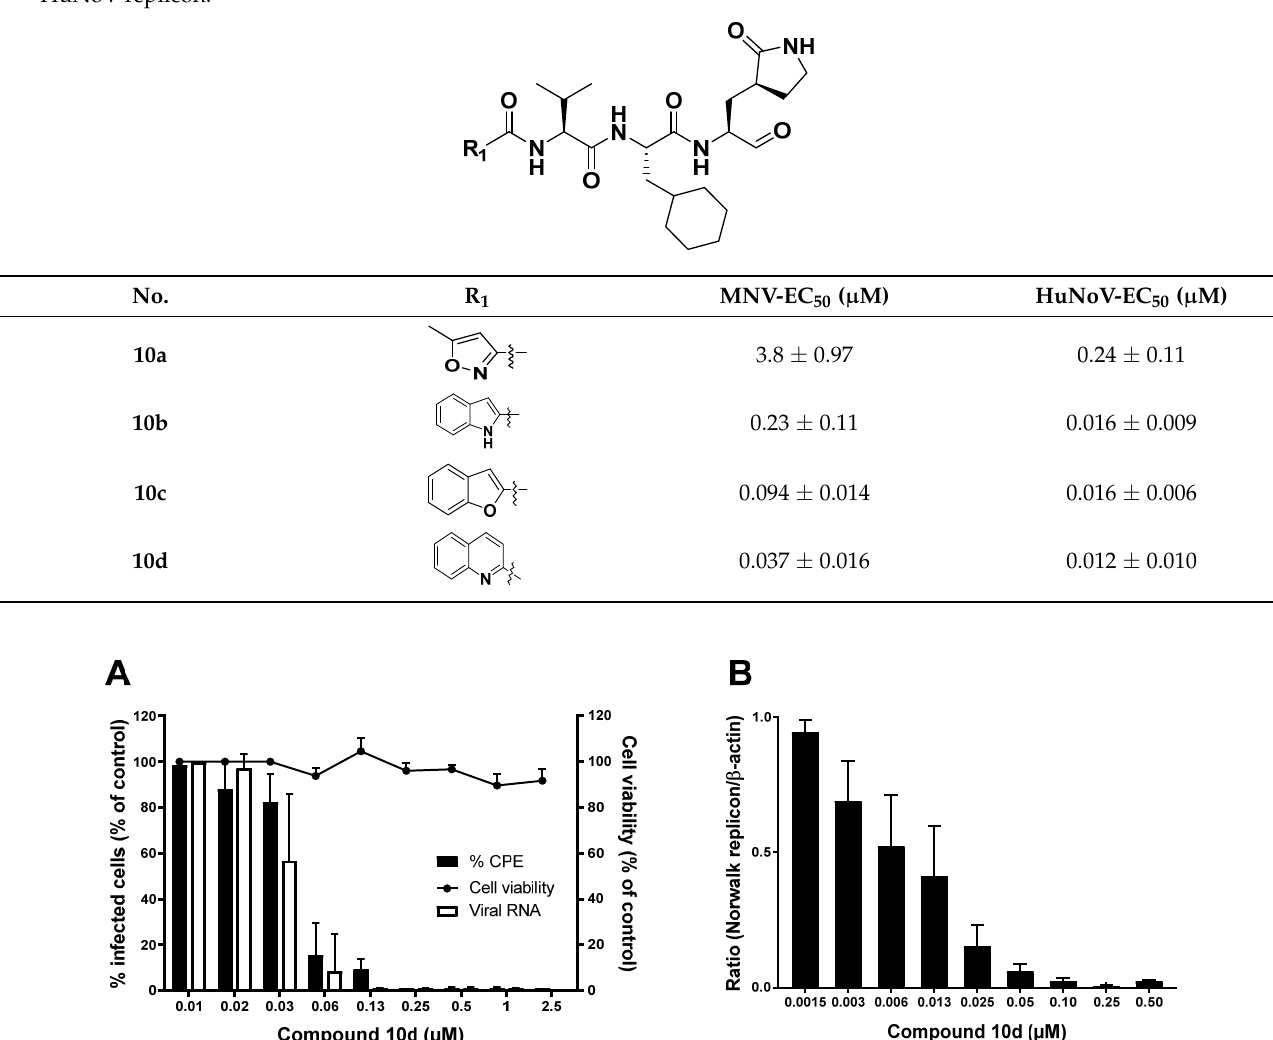
Table 2. Structures of tetrapeptide inhibitors with R 1 modifications and their antiviral activities against MNV and the HuNoV replicon.